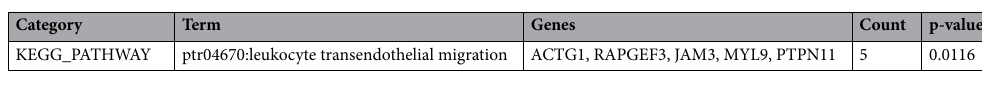
Table 5. Pathway analysis of downregulated genes in